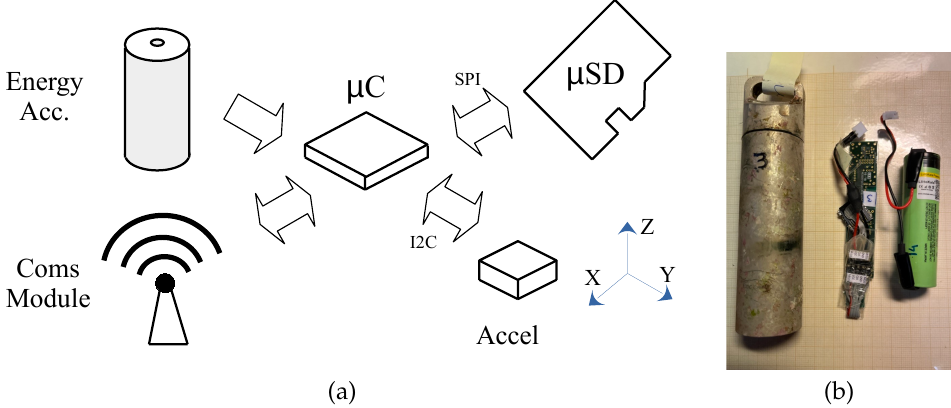
Figure 5. A block diagram of ( a ) the measurement unit architecture and ( b ) the fabricated